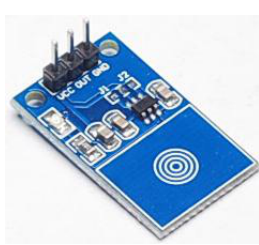
Figure 7. TTP223 human touch module.